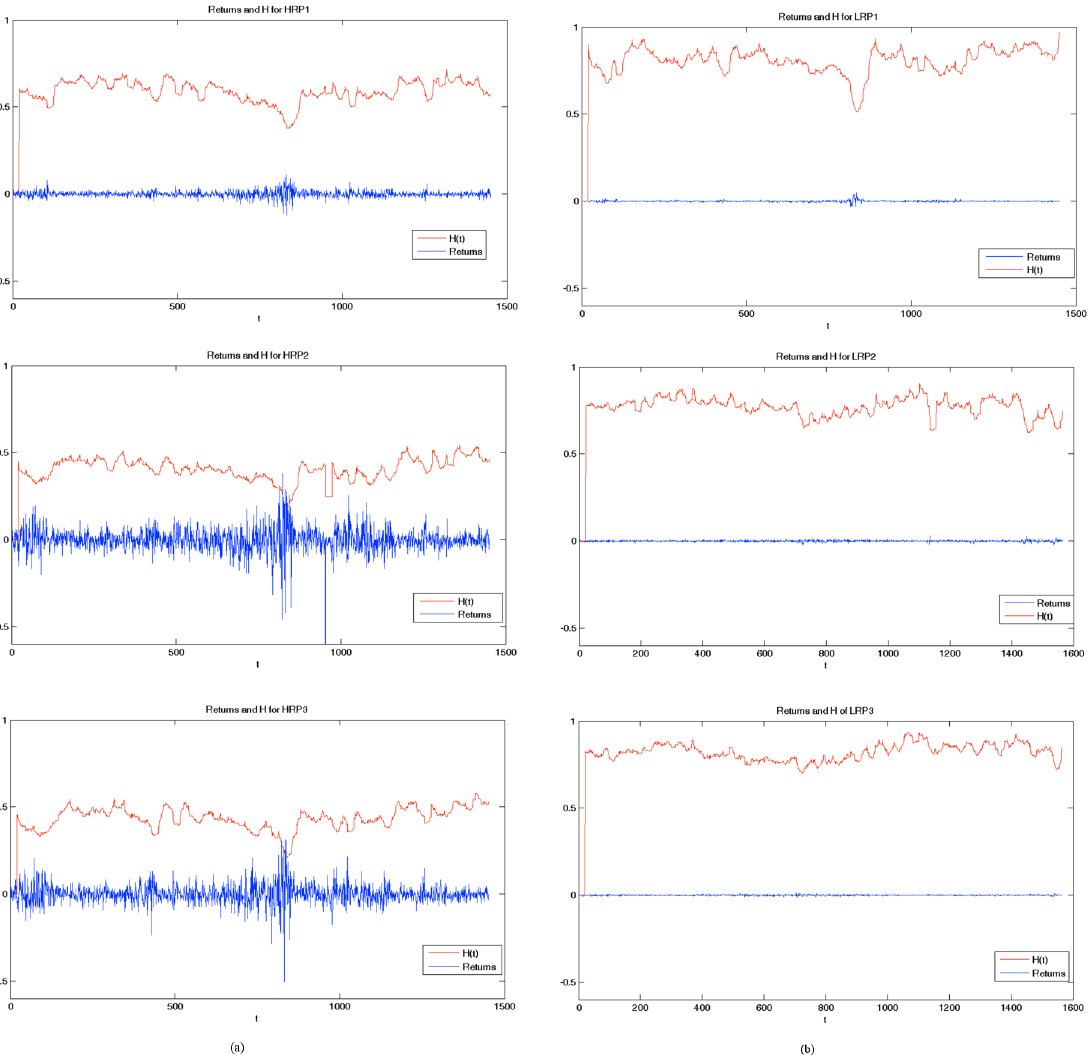
Fig 3. H and returns of the portfolios. Estimated H and returns for three high risk portfolios (column (a)) and three low risk portfolios (column (b)). The lag for the estimation of H was set to 20 days for all portfolios.